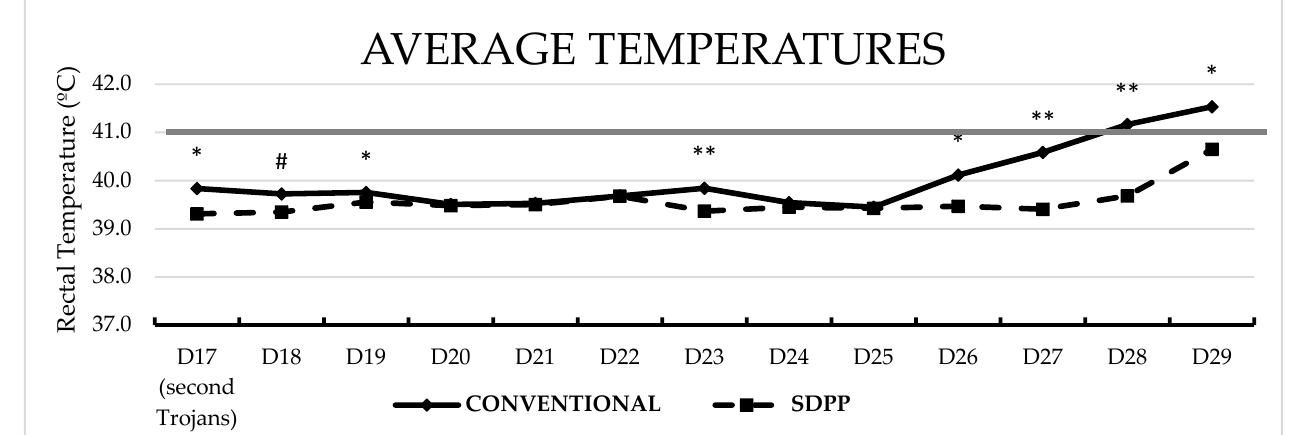
Figure 3. Average rectal temperature over time between treatments after second ASFV exposure. # = p < 0.1; * = p < 0.05; ** = p < 0.01 SDPP = spray-dried porcine plasma.